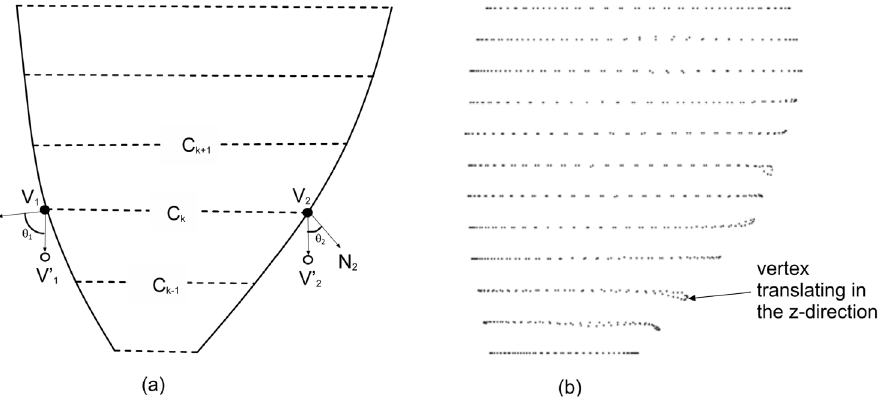
Figure 4. Constraint in the z axis. (a) Angle h between vertex normal N and the z -axis, and the impact on volume change due to translation, (b) LV epicaridal surface modified by the free-form deformation process.